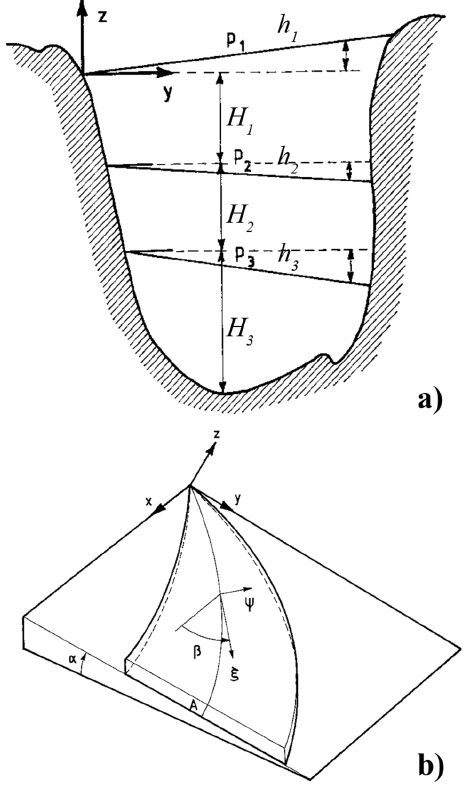
Figure 2. (a) Schematic representation of the three layers in a cross- flow vertical transect. The interfaces are at z = h 1 for the air–sea surface, at z = H 1 + h 2 , and at z = H 1 + H 2 + h 3 for the lower in- terfaces, with H 1 = const and bottom depth= H 1 + H 2 + H 3 . (b) Di- agram of a bottom current also showing the ( x , y) and ( ξ , ψ) coor- dinate systems. Modified from Astraldi et al.